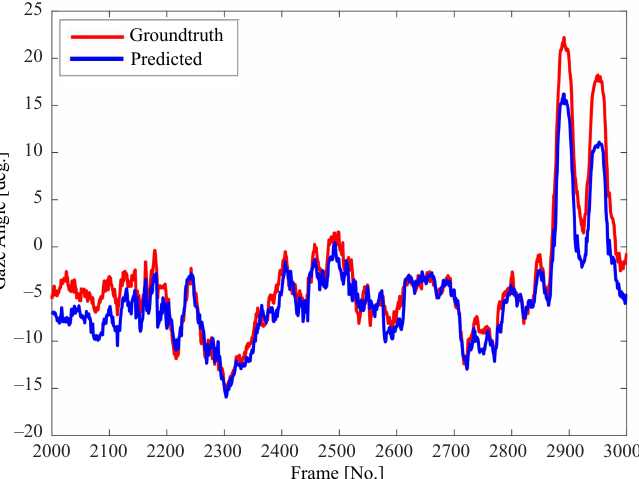
Figure 8. Comparison between the predicted value and the ground-truth value of pitch angle.